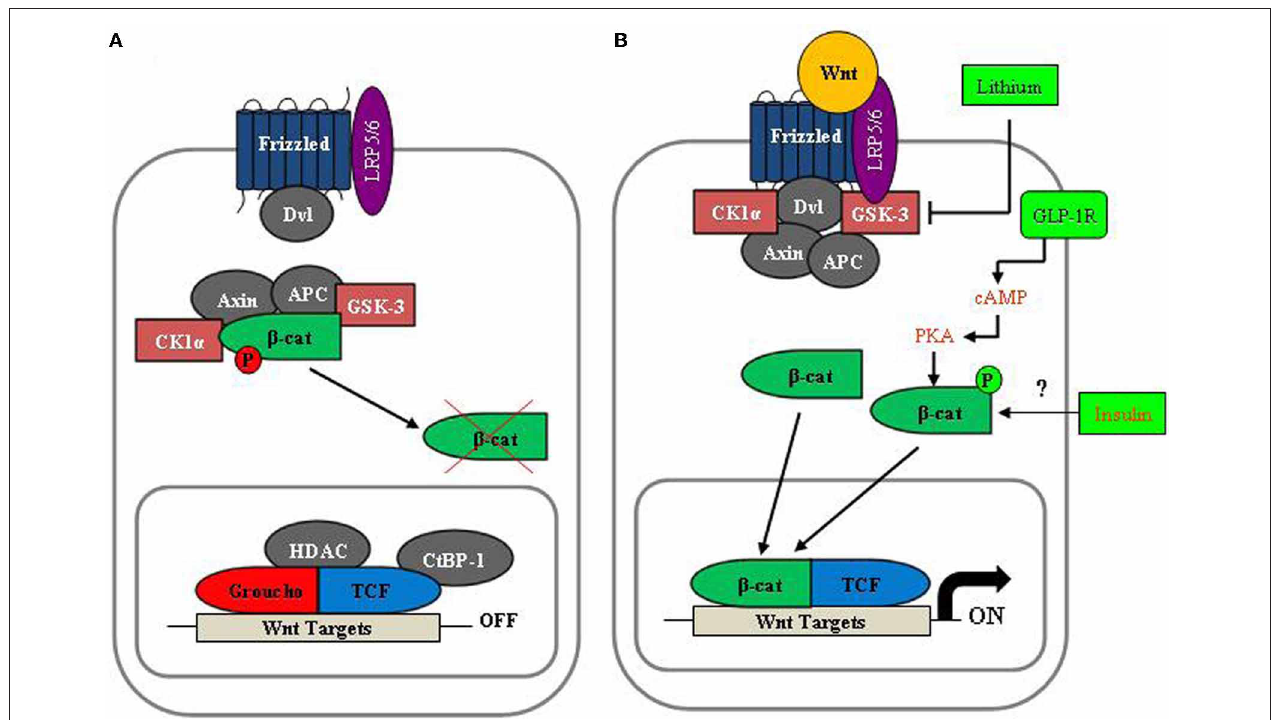
FIGURE 5 | A simplified illustration of the canonical Wnt signaling pathway. (A) In the absence of Wnt ligand stimulation, β -cat is located within the “destruction complex”, phosphorylated by GSK-3 and CK-1 α at Ser33 and adjacent serine positions, which leads to proteasome-mediateddegradation process. (B) Following Wnt ligand stimulation, the destruction complex disassembles, resulting in free β -cat accumulation. It then enters the